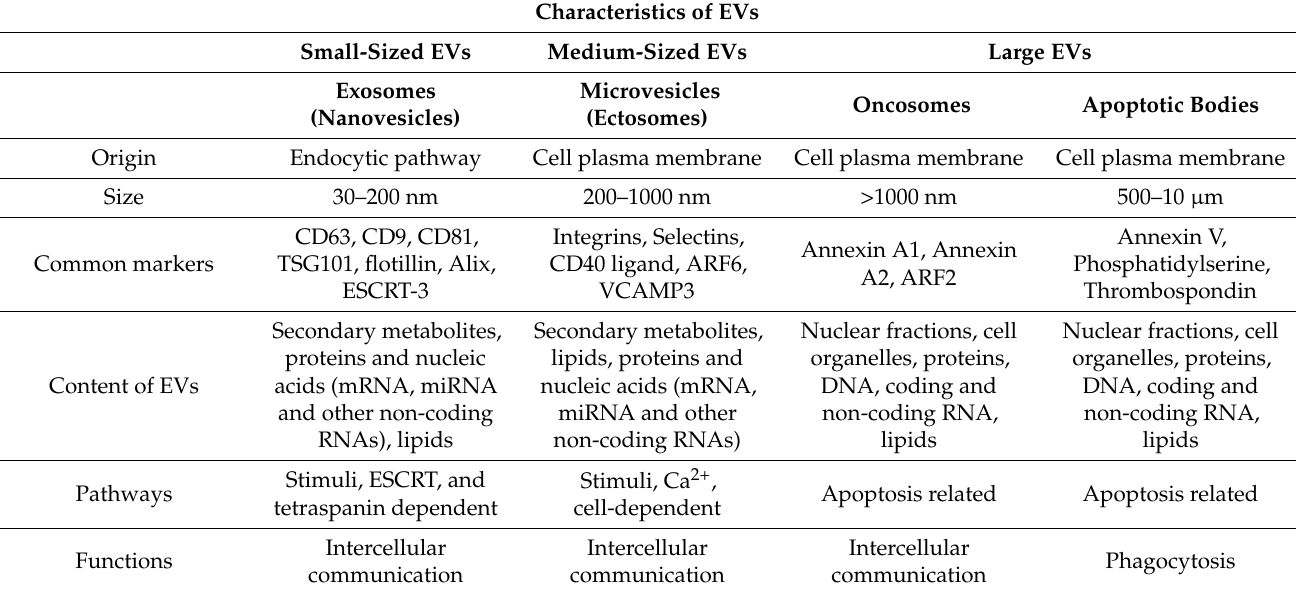
Table 1. Classification of EVs